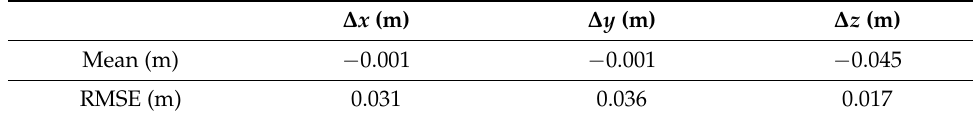
Table 3. Final accuracy of airborne point cloud using the amorphous object method.